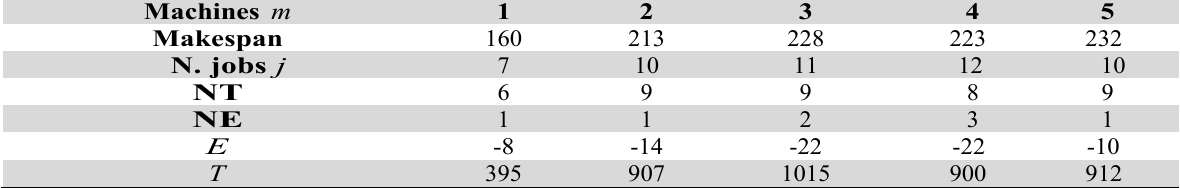
Results of the optimum solution chosen in the first scenario.